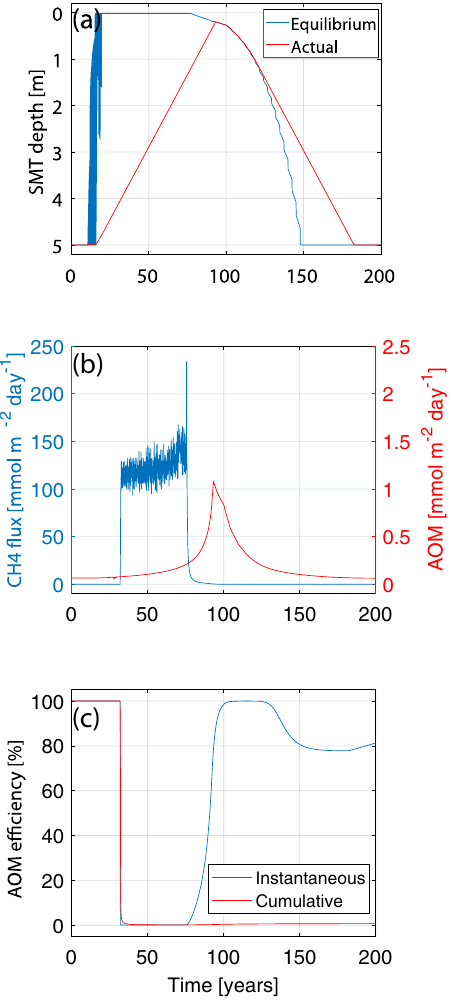
Fig. 4 Model output from Case A with clayey sediments ( k = 10 − 17 m 2 ). a The equilibrium/actual depth of the sulfate-methane transition (SMT) (blue/red). b CH 4 fl ux at the sea fl oor (blue) and anaerobic oxidation of methane (AOM) integrated over the SRZ (red). Note the different scales (two orders of magnitude difference). c AOM fi lter ef fi ciency calculated from instantaneous fl uxes (blue) and from the cumulative fl uxes (red). Corresponding data for clayey silt ( k = 10 − 15.5 m 2 ) and clean sand ( k = 10 − 14 m 2 ) are shown in Supplementary Fig.